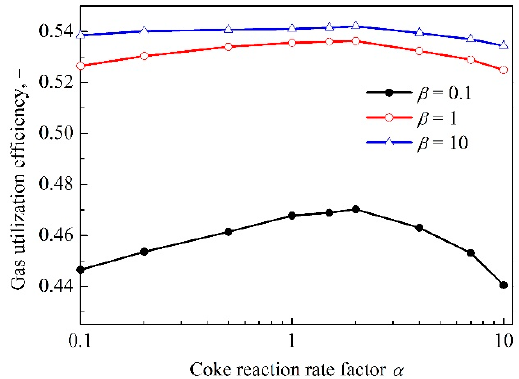
Figure 7. The relationship between the gas utilization efficiency and iron ore reducibility.